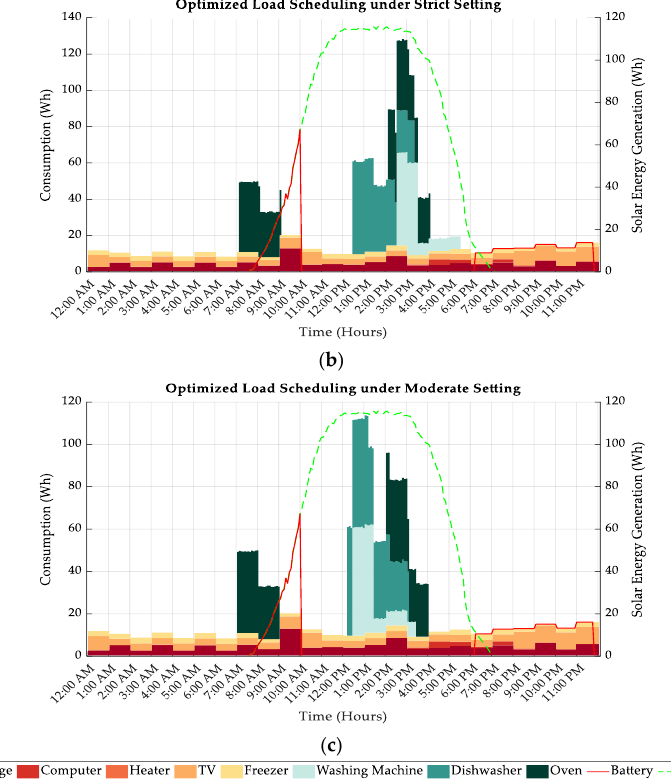
Figure 5. Resulting Load Profiles from Scenario 2. ( a ) Load Scheduling for the Flexible Setting; ( b ) Load Scheduling for the Moderate Setting; ( c ) Load Scheduling for the Strict Setting.